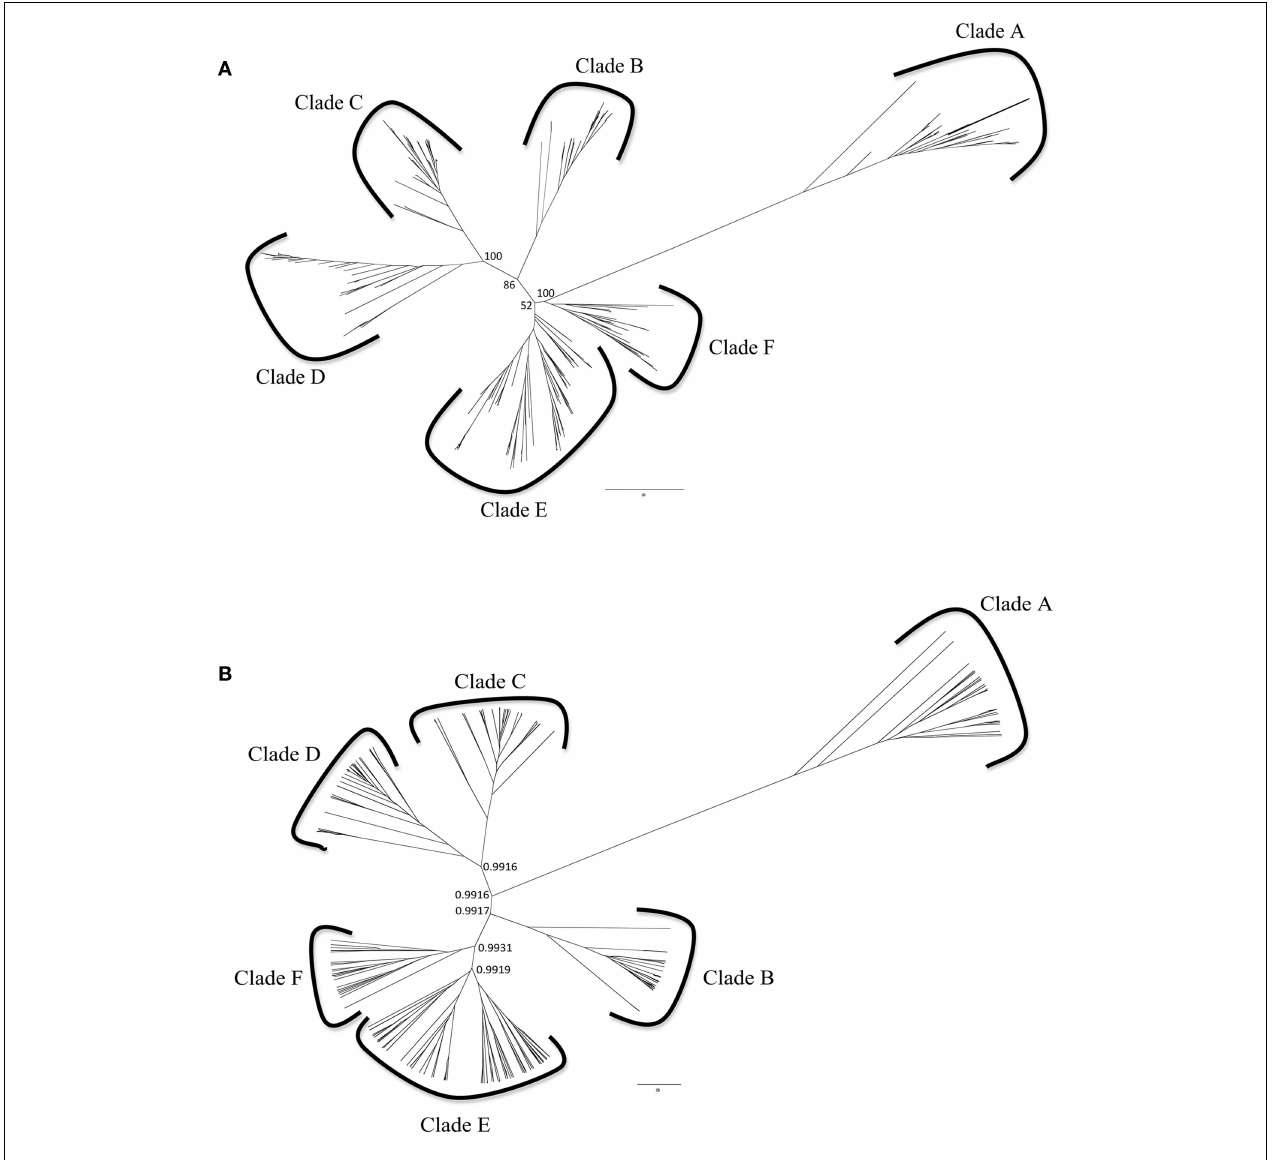
probabilities are shown for the deep branches defining the six [Ni,Fe]-CODH clades.The compositions of all six clades in both ML and BI trees are identical (see FigureA1 in Appendix andTable S3 in Supplemental